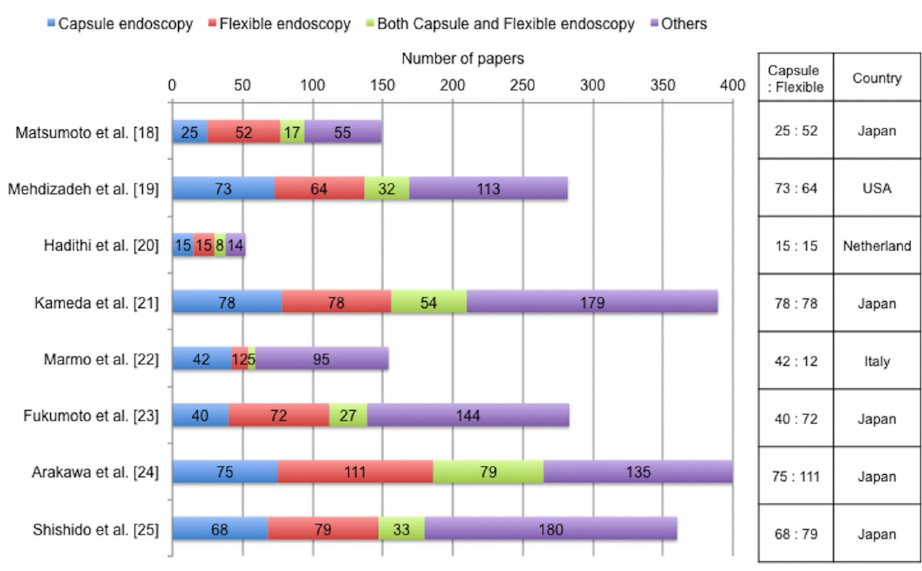
Fig 6. The number and categories of papers published by all authors of the eight postmarketing studies. A total of 2069 papers were found using PubMed (MEDLINE). The contents were summarized as the following four categories: capsule endoscopy, flexible endoscopy, both capsule and flexible endoscopy, and others not related to capsule or flexible